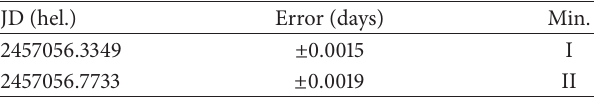
Table 1: New CCD times of light minimum for V921 Her. Table 2: (𝑂 − 𝐶) values of light minimum for V921